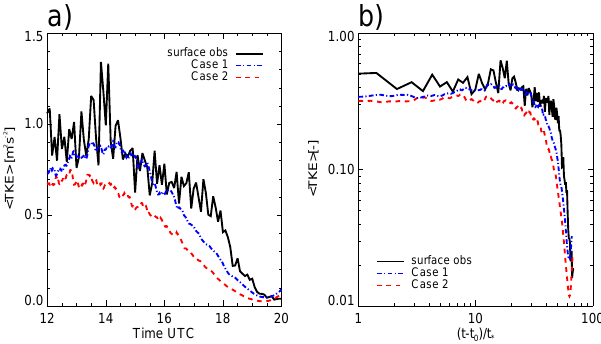
Figure 14. Temporal evolution of TKE in the boundary layer. Left panel: surface measurements and DALES experiment cases 1 and 2. Right panel: non-dimensional measurements and DALES